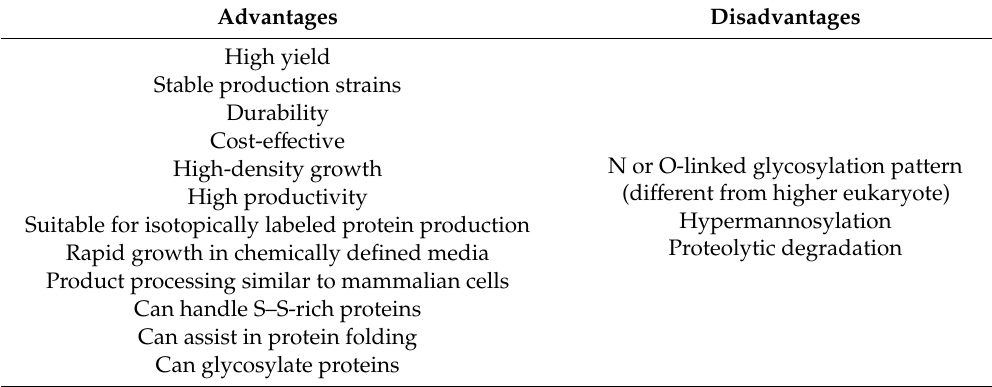
Table 2. Advantages of yeast expression systems.